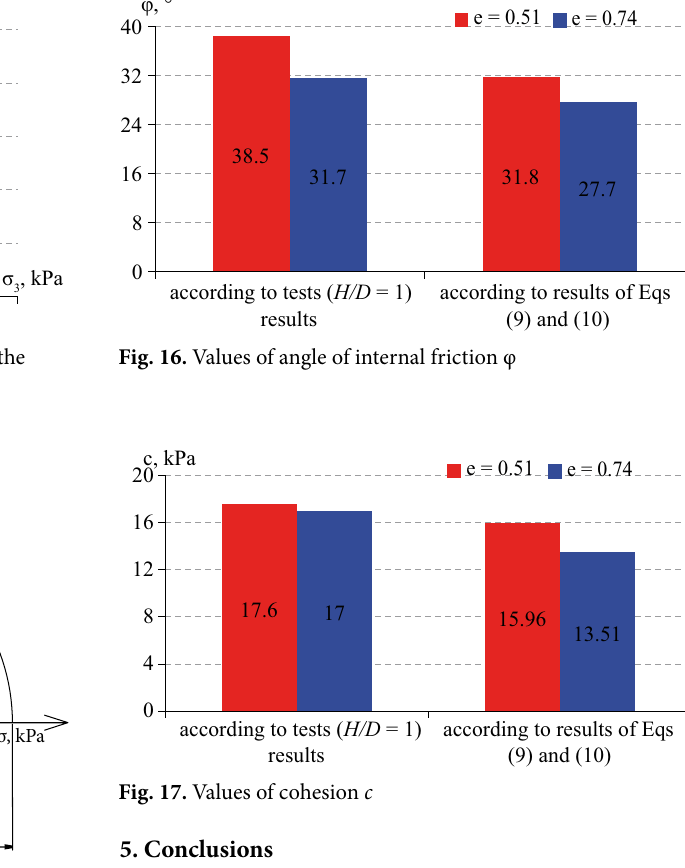
Fig. 14. Mohr cycles for dense sand